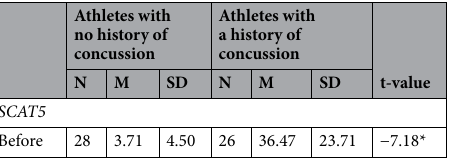
Table 2. Severity scores on the concussion scale (SCAT5) before VR acquisition. * p < 0.05.